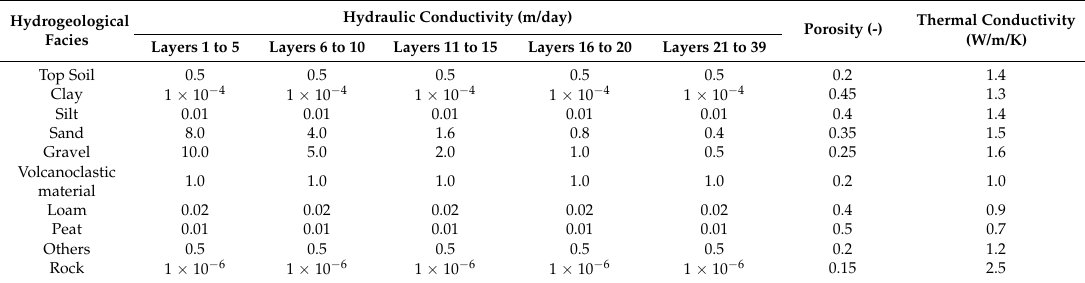
Figure 2. Analysis model of the Aizu Basin. Reprinted by permission from Springer Customer Service Centre GmbH: Springer HYDROGEOLOGY JOURNAL (Performance evaluation of a ground-source heat pump system utilizing a flowing well and estimation of suitable areas for its installation in Aizu Basin, Japan, Shrestha et al., 2017). Table 1. Parameters of analysis model.